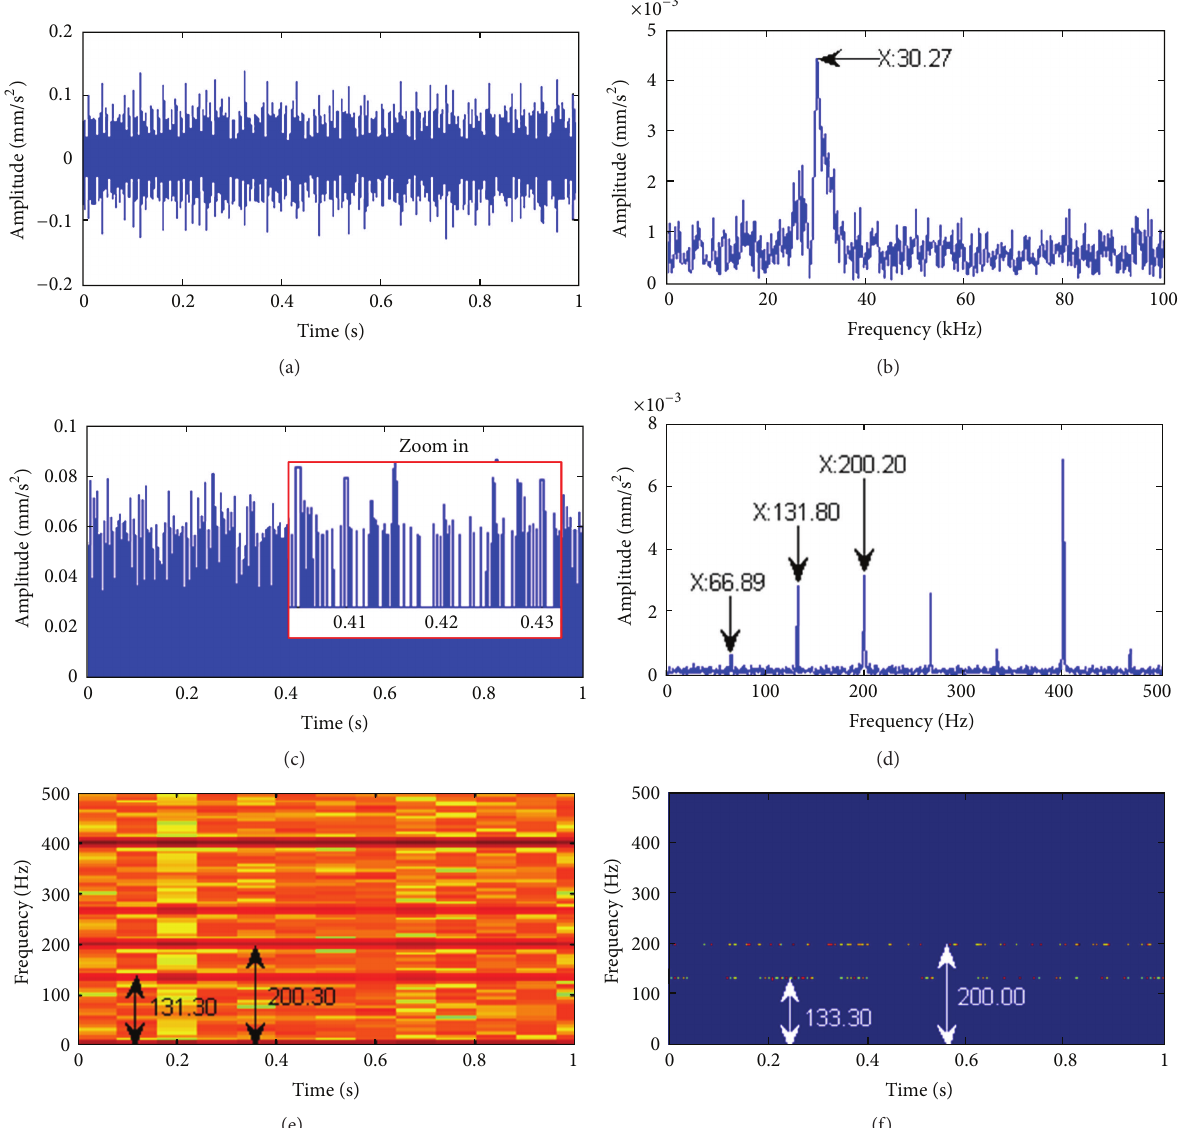
Figure 10: (a) The time domain waveform of 𝑥(𝑡) ; (b) the amplitude spectrum of 𝑥(𝑡) ; (c) the processing result of 𝑥(𝑡) by SPM; (d) the processing result of 𝑥(𝑡) by shock pulse frequency spectrum analysis method; (e) the processing result of 𝑥(𝑡) by shock pulse time-frequency analysis method; (f) the processing result of 𝑥(𝑡) by